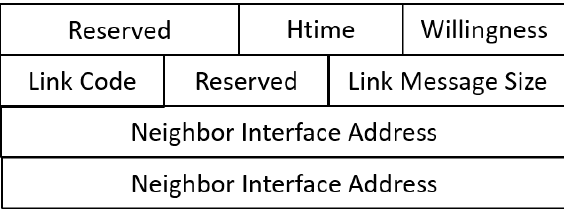
Figure 1. How MANET Nodes Work with OLSR.